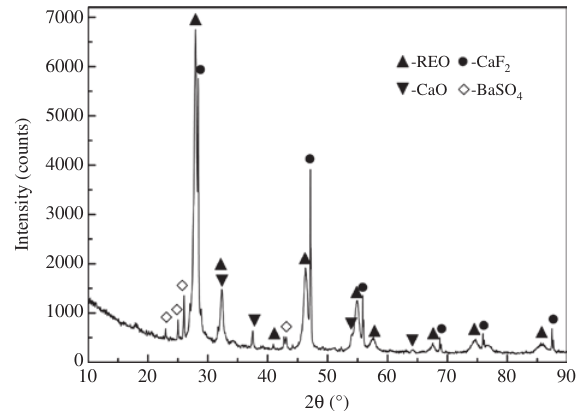
Figure 5: X-ray diffraction pattern of S1 roasted at 650 ° C.